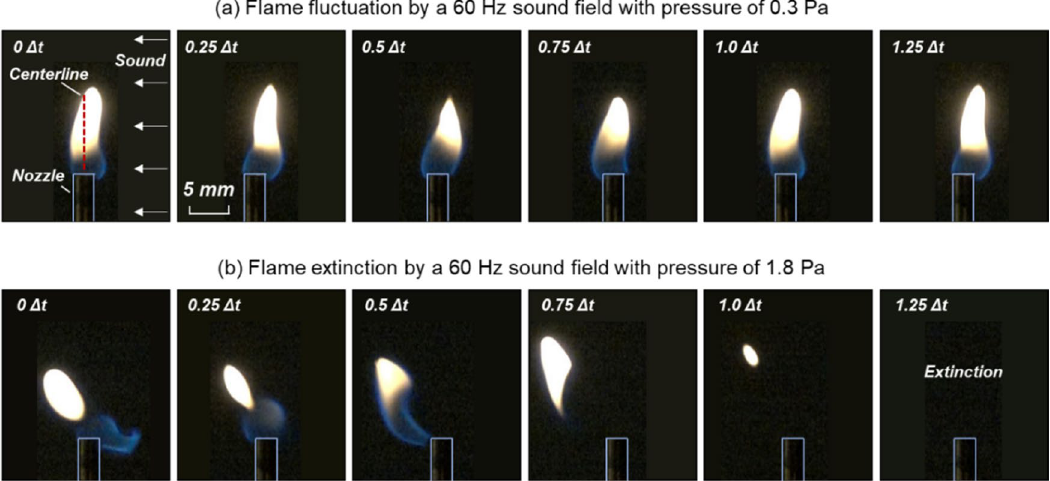
Figure 3. Behaviors of a 15-mm flame inside a 60-Hz sound field with a pressure of ( a ) 0.3 Pa (Video S1) and ( b ) 1.8 Pa (Video S2), where Δt = 16.7 ms is the acoustical